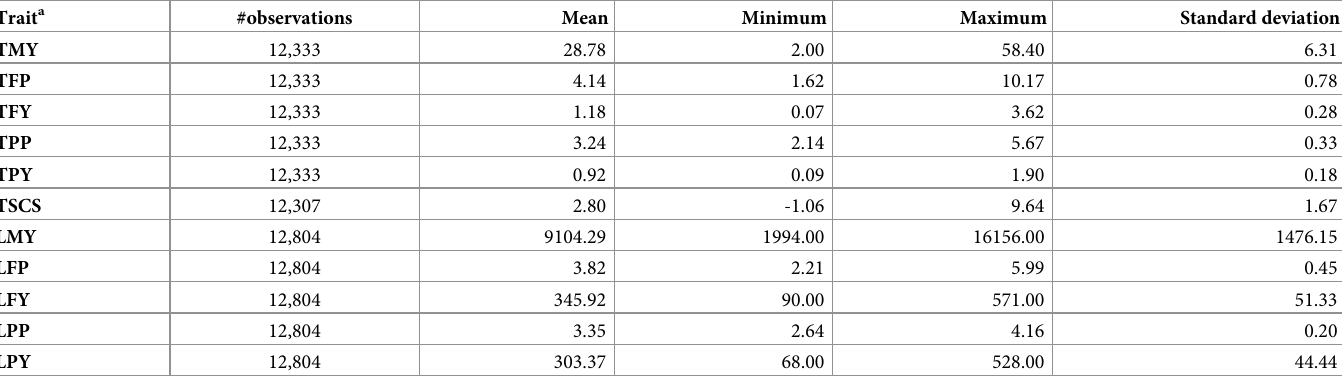
Table 1. Descriptive statistics of first test-day and lactation production